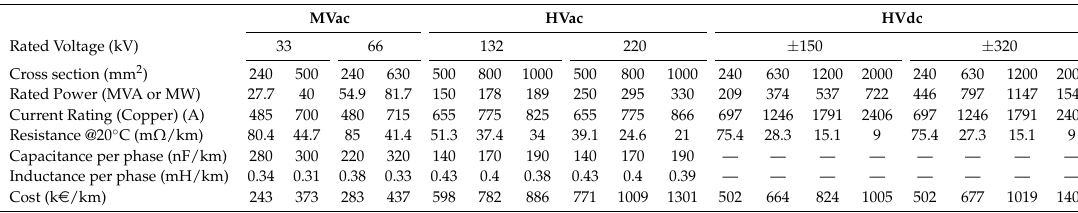
Table 5. Parameters of the cables used in the case study [97,98,100].